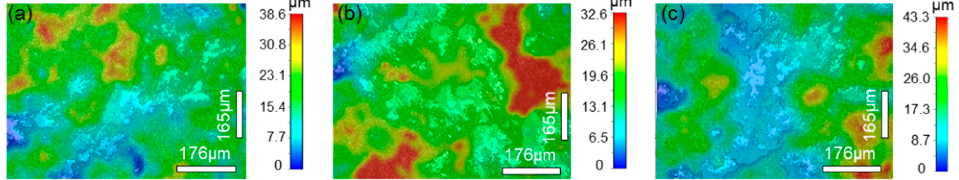
Figure 14. LSCM images of the wear tracks on the 27CrMoV substrate at ( a ) 1000 g, ( b ) 1500 g, and ( c ) 2000 g.